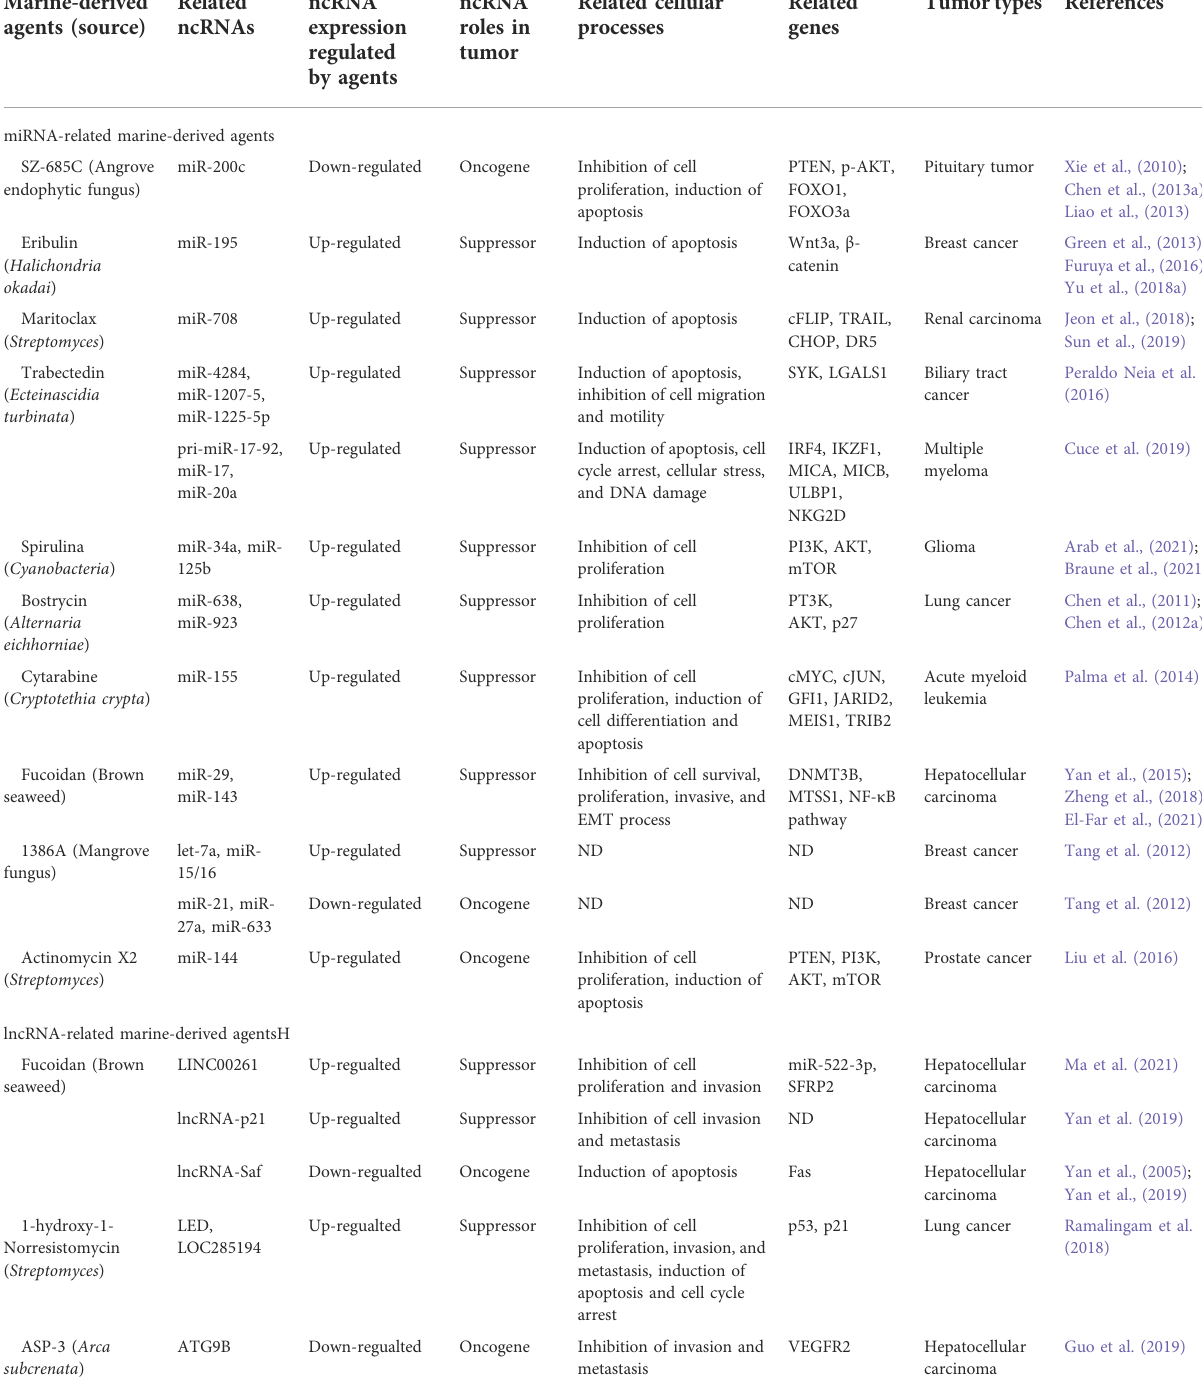
TABLE 1 Marine-derived agents associated with ncRNAs in tumor fundamental cellular